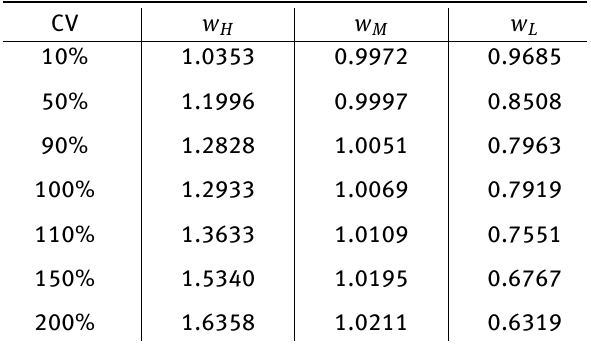
Table 2: Weight factors of the GB2 posterior mean under all scenarios and parameter